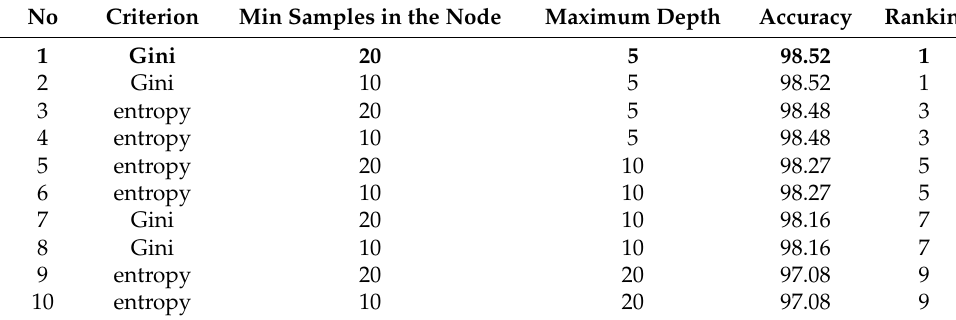
Table 6. J48 DT algorithm hyperparameter optimization results.